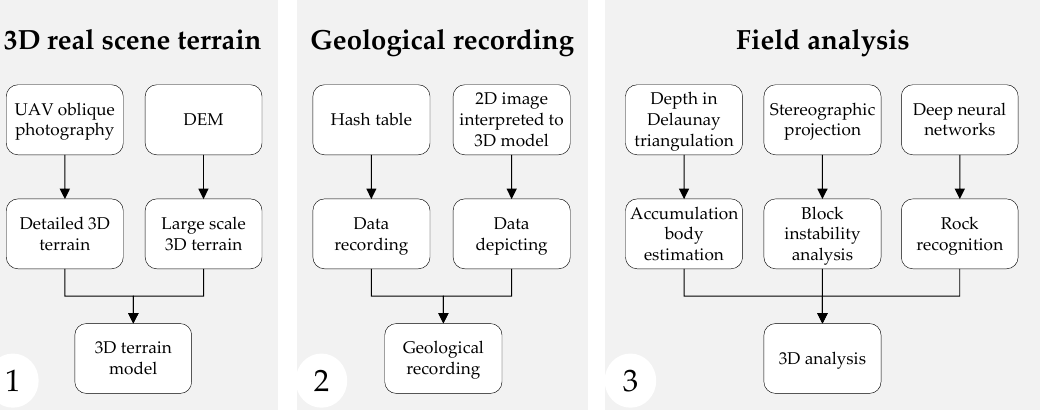
Figure 1. Methodology architecture.